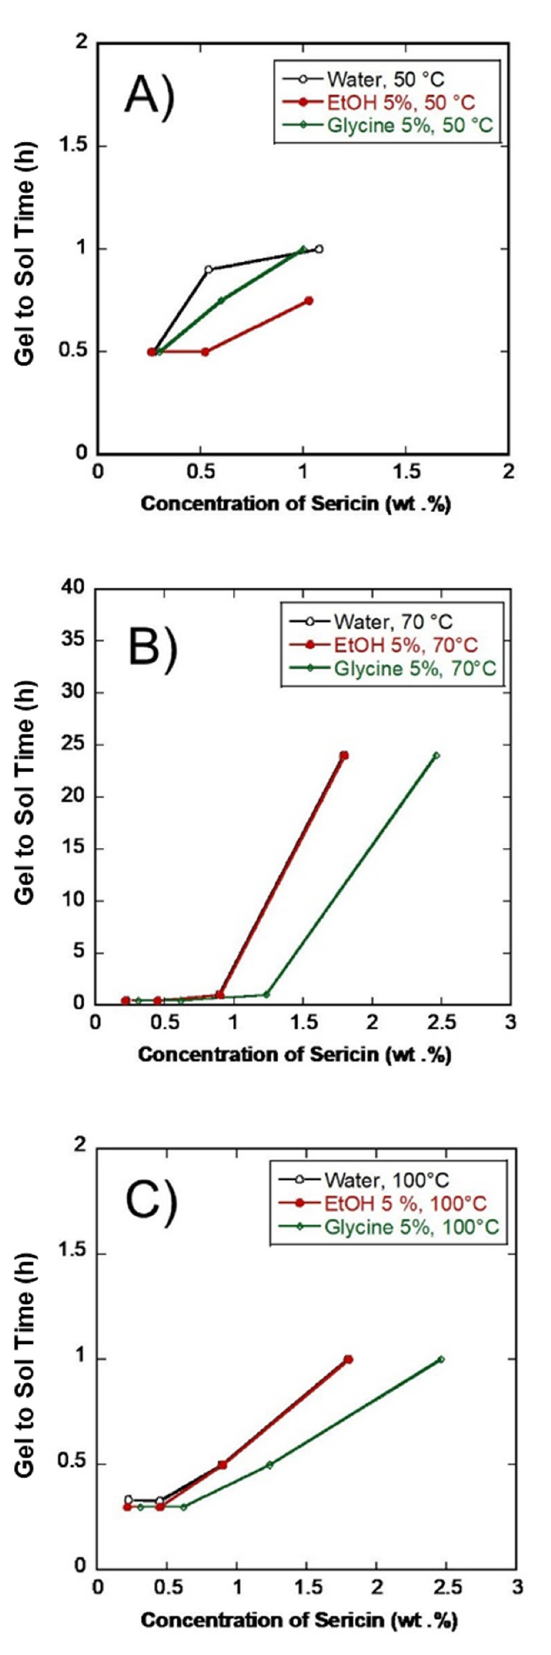
Figure 9. Gel to sol transition at different temperatures. ( A ) At 50 °C; ( B ) at 70 °C; ( C ) at 100 °C.